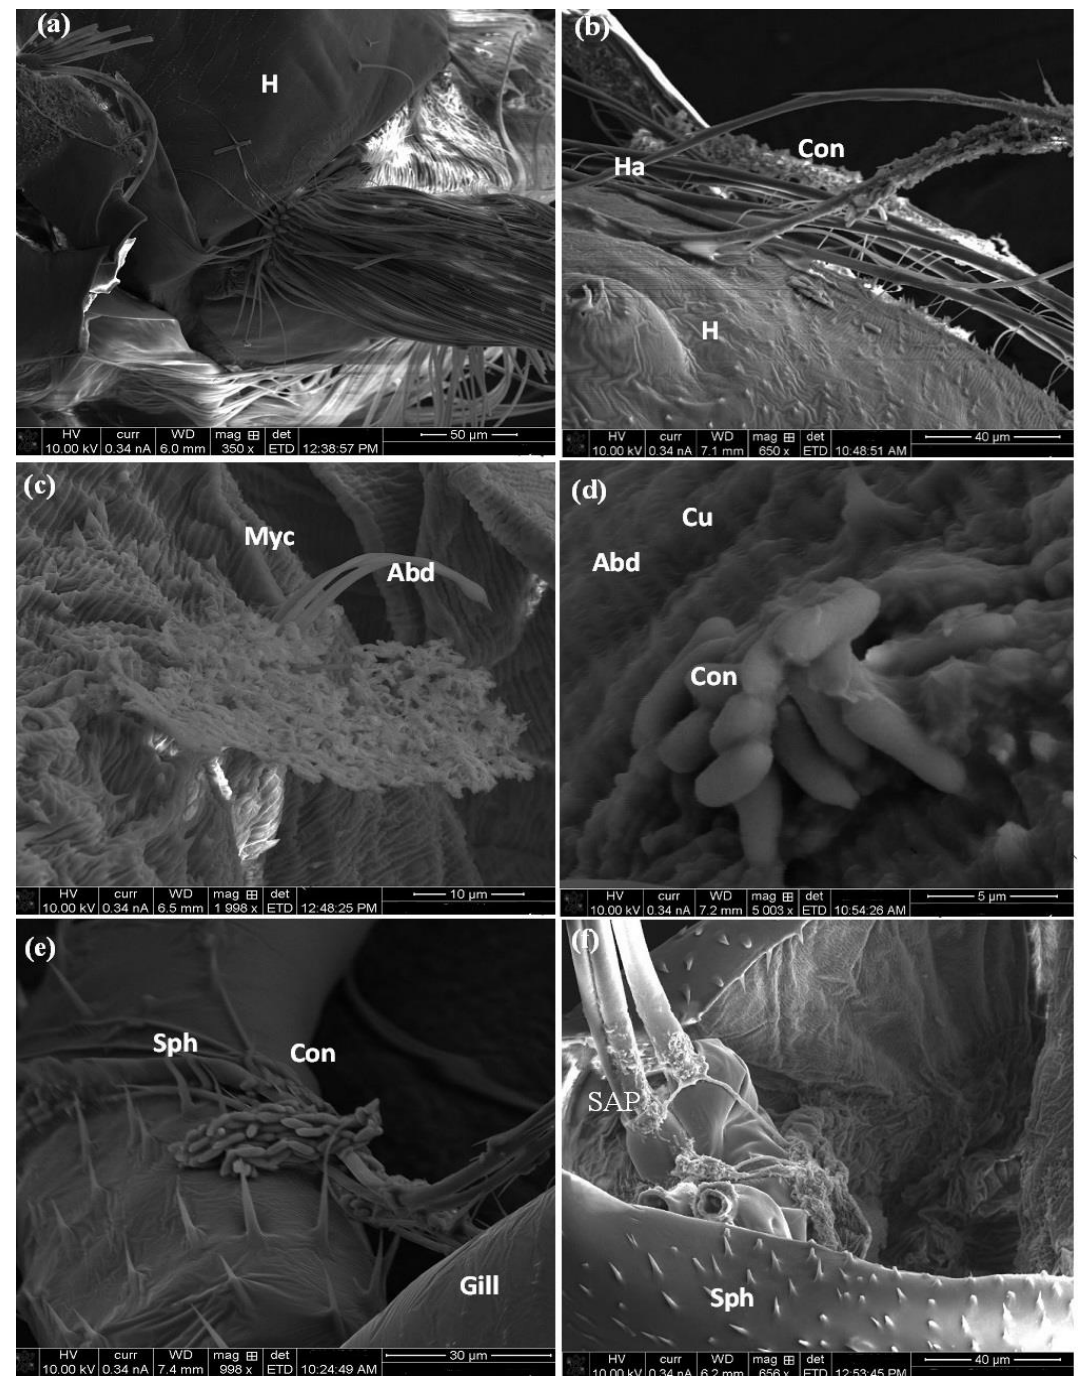
Figure 10. SEM of larval body surface (head, abdomen, and respiratory siphon, gills) of C. pipiens treated with fungus, M. brunneum . ( a , b ) M. brunneum adheres to the hair of the head. ( c , d ) attachment of M. brunneum to the abdominal cuticle and ( e , f ) to the respiratory system. (Abd: Abdomen, Co: conidia, Cu: cuticle, Gill: gills, H: head, Ha: head hair, Siph: siphon, SAP: spiracular apparatus). To elucidate whether the effect of Co 3 O 4 nanorods is beneficial as an effective larvi- cidal nanomaterial, we compared the synthesized nanorods results with the fungus. The mortality rates were estimated to be 100% for NRs and 97.5% for the fungus. Therefore, the Co 3 O 4 NRs were more effective in the control of mosquito larvae.